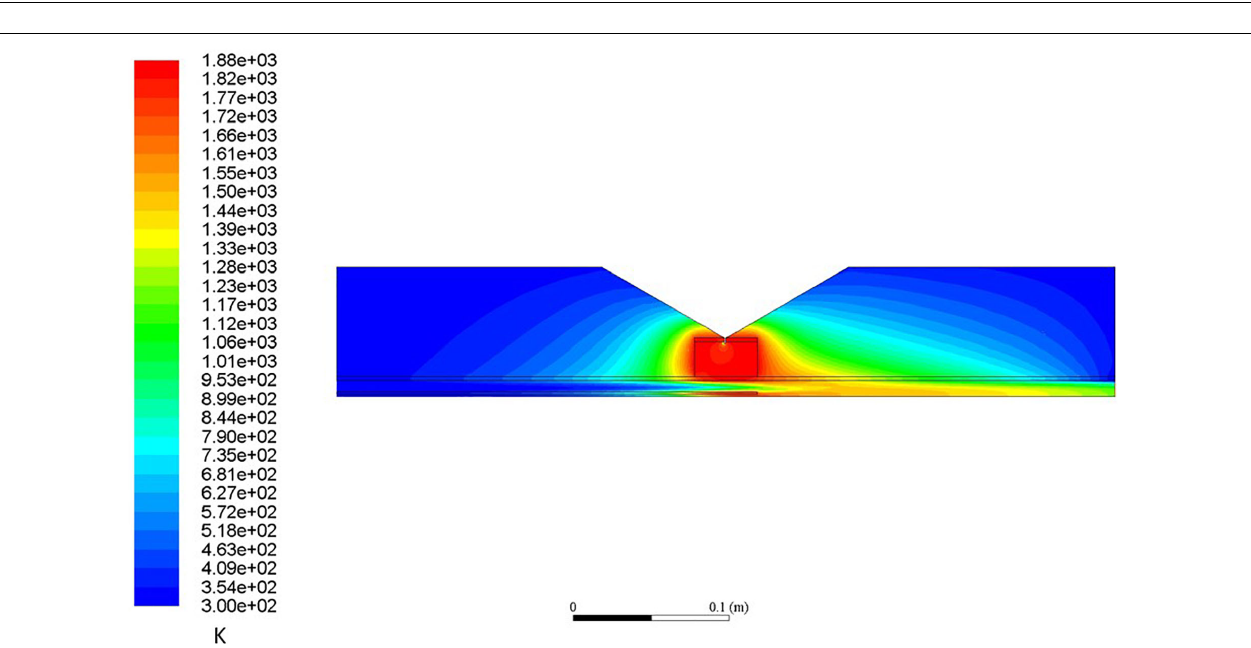
FIGURE 4 | Temperature of the outer tube inner wall (continuous line) and on the symmetry axis (dashed line) for the three configurations (single tube, dual tube 270 mm, dual tube 230 mm length) vs. reactor length.